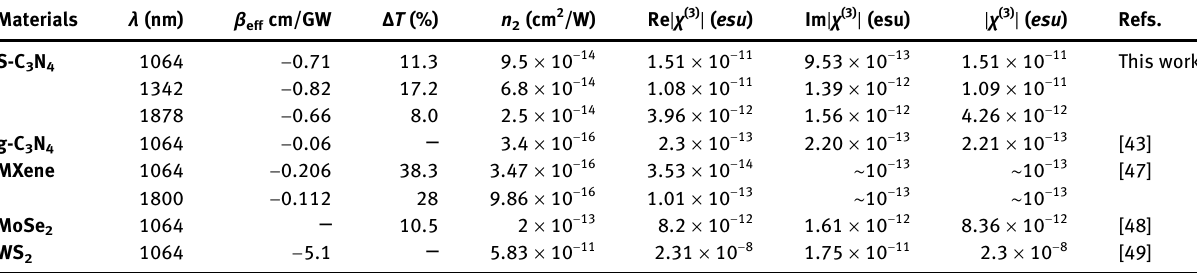
Table  : The broadband nonlinear parameters of S-C  N  and its comparison with that of other two-dimensional materials.